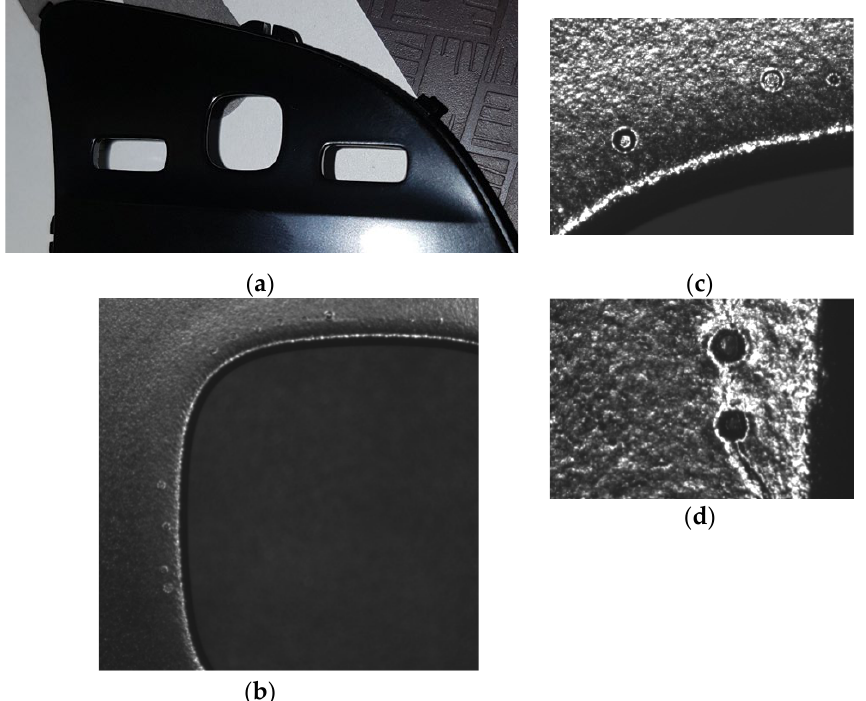
Figure 7. Coated parts analysis: ( a ) Visual test; ( b ) Optical microscopy analysis of the rectangle window of the part; ( c ) Optical microscopy analysis on the upper zone of the rectangle window; ( d ) Optical microscopy analysis on the right zone of the rectangle window.